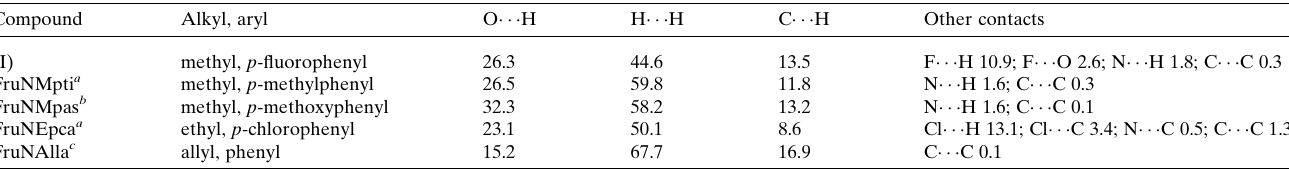
Table 3 Contributions (%) of specific contact types to the Hirshfeld surfaces of (I) and other N , N -alkylaryl derivatives of d -fructosamine. Compound